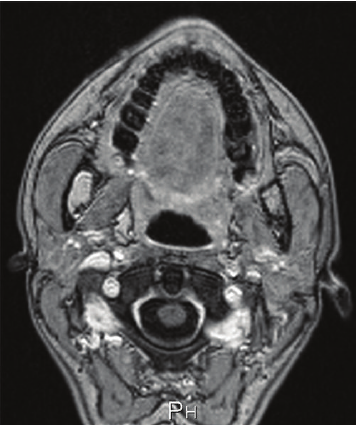
Figure 3: MRI showed the lesion with signal reduction in the sequences with fat suppression.